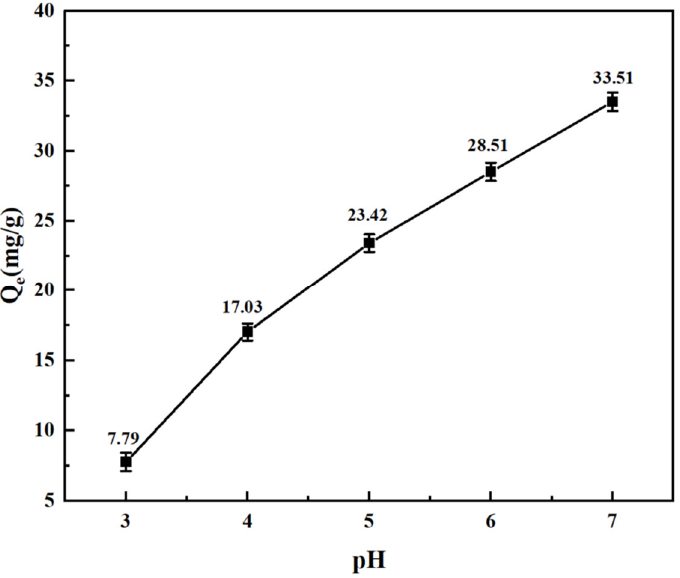
Figure 13. Effects of pH on the adsorption of Cu 2+ onto SA-Ch.